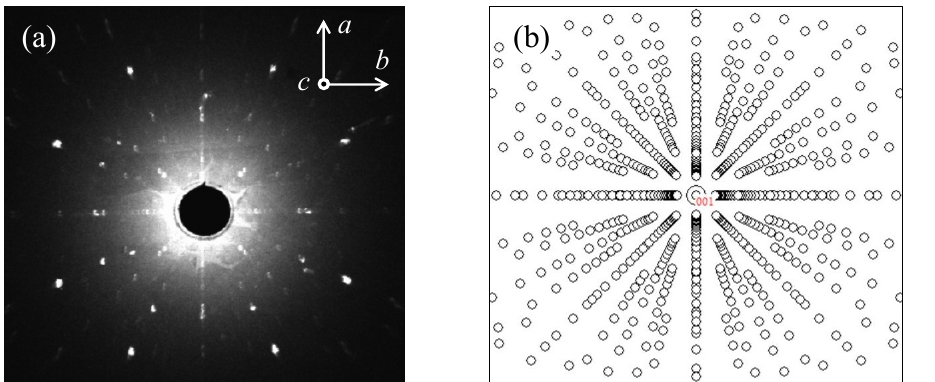
Figure 3. (color online) ( a ) One representative in-house X-ray Laue pattern of a La 1.37 Sr 1.63 Mn 2 O 7 single crystal with real-space lattice vectors marked. The incoming X-ray beam is perpendicular to the plane of the Laue spots and thus is along the unit-cell c axis. ( b ) Corresponding simulation of the X-ray Laue pattern with the software “OrientExpress”